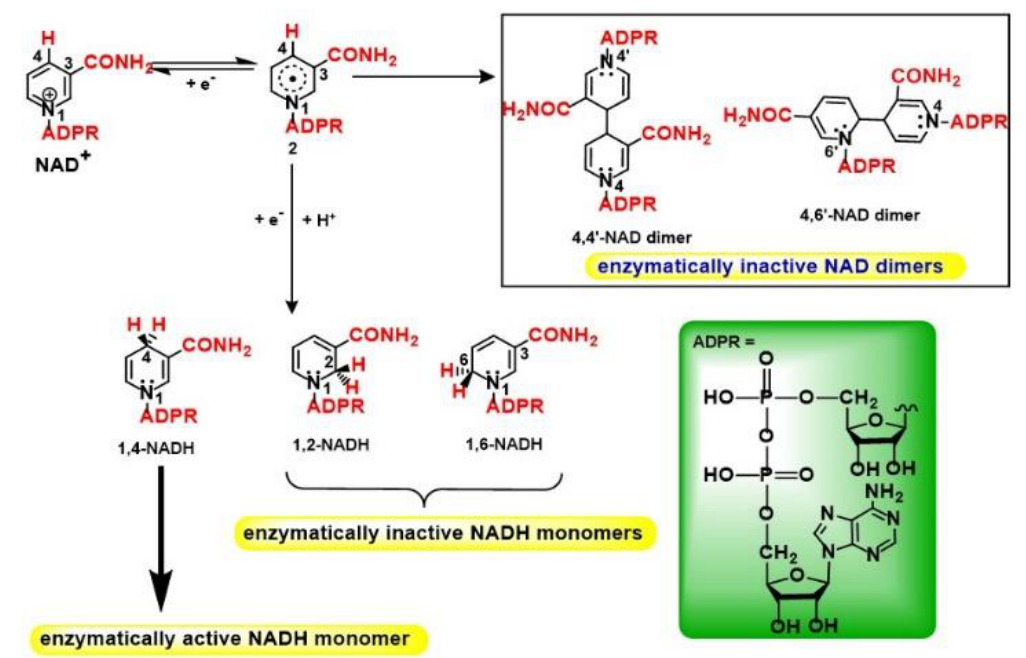
Figure 5. The negative potential graph of ( a ) NGQDs ( − 11.8 mV) and, ( b ) NGQDs@EC photocatalyst ( − 29.2 mV).